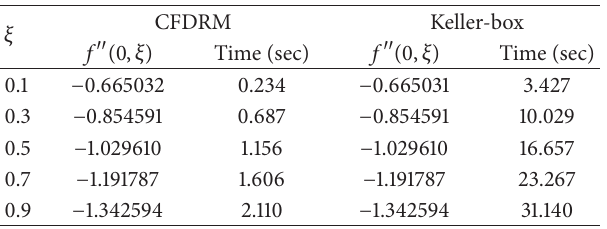
Table 1: CFDRMand Keller-box resultsfor theskin friction 𝑓 󸀠󸀠 (0,𝜉) in Example 1 when 𝑀 = 1